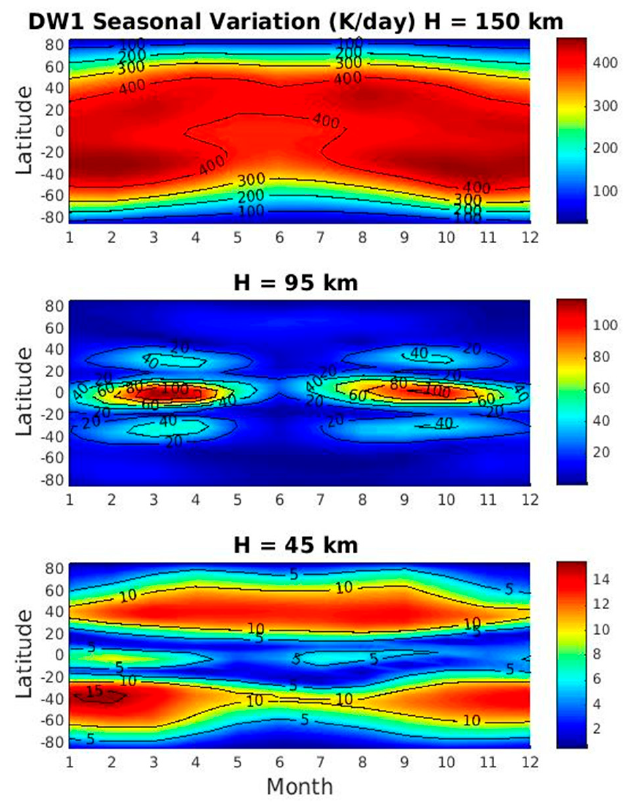
Figure 2. Seasonal variations of the time tendency (K/day) on the left-hand-side ( LHS ) of thermodynamic budget Equation (1) for DW1 at 45, 95 and 150 km. The LHS is simply the DW1 T amplitude times